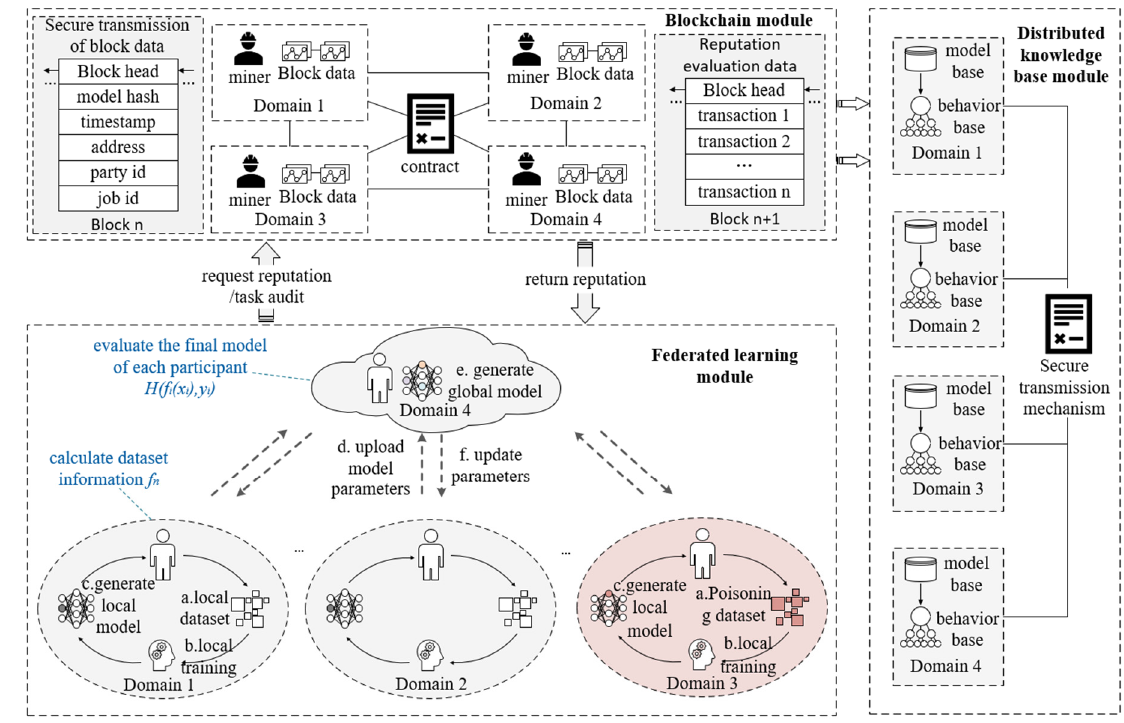
Figure 1. Overall framework.